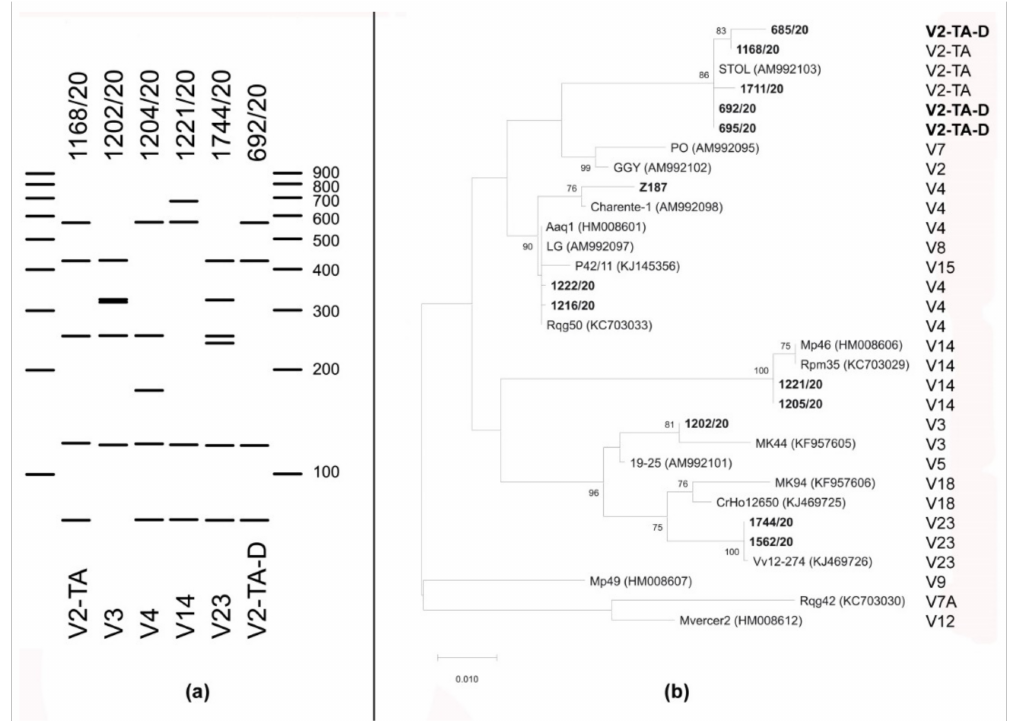
Figure 2. Analyses of the vmp1 gene (TYPH10F/R amplicon). ( a ) Representative virtual RFLP gel showing the vmp1 patterns digested with the Rsa I restriction enzyme of the ‘ Ca . P. solani’ strains obtained in this work (stated above) with corresponding vmp1 profile (stated below) of the reference ‘ Ca . P. solani’ isolate shown in panel b. Fragment sizes of the marker are indicated in base pairs. ( b ) The evolutionary history was inferred using the Maximum Likelihood method applying the GTR model of 31 vmp1 sequences of ‘ Ca . P. solani’ strains obtained in this work and selected reference strains. The tree with the highest log-likelihood is shown. Accession numbers are given in parentheses. The tree is drawn to scale, with branch lengths measured in numbers of substitutions per site. Vmp1 sequences of the ‘ Ca . P. solani’ strains obtained in this work and newly described restriction patterns are in